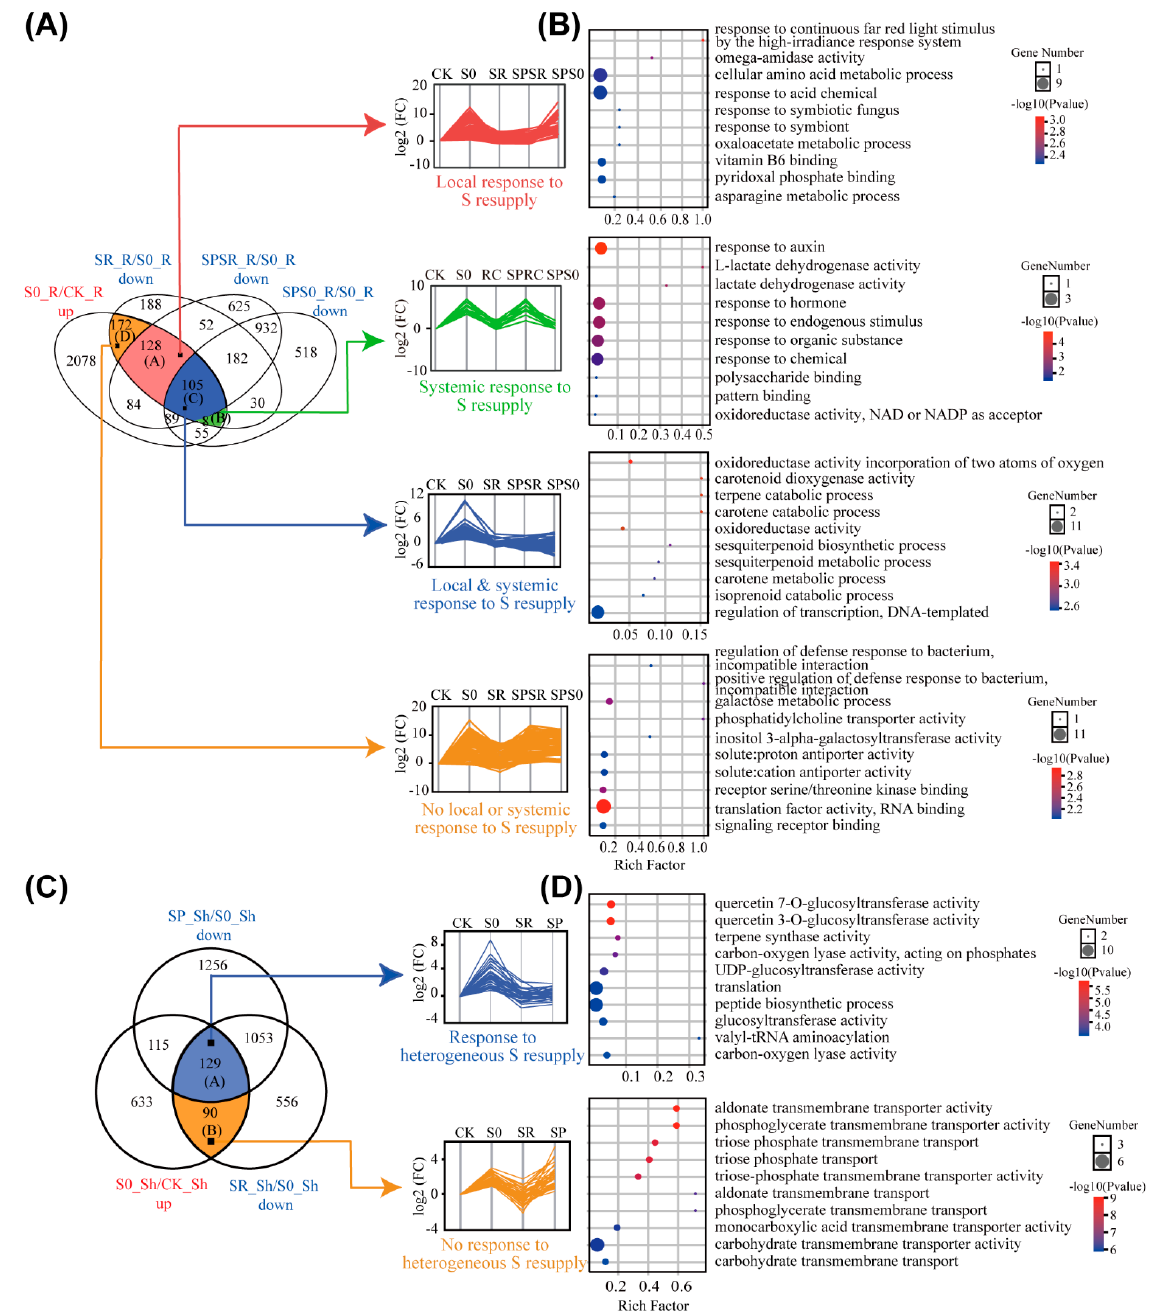
Figure 4. Root and shoot up-regulated DEGs in response to homogeneous and heterogeneous sulfate resupply. ( A ) Identification of root up-regulated DEGs with local response, systemic response, simultaneous local and systemic response, and no response to sulfate resupply by gene expression trend analysis and Venn diagramming. Different types of response genes were classified into Gene set A, B, C, and D, respectively, as shown in Table S5. ( B ) GO enrichment analysis of different types of response genes in ( A ). The top 10 GO terms with lowest p -values were shown. ( C ) Identification of shoot up-regulated DEGs responding to homogeneous and heterogeneous sulfate resupply, which were classified into Gene set A and B as shown in Table S6. ( D ) GO enrichment analysis of different types of response genes in ( C ). The top 10 GO terms with lowest p -values were shown. CK, control; S0, S deficiency; SR, sulfate resupply in both sides of split-roots; SPSR, the split-root halve with sulfate resupply; SPS0, the split-root halve remained in S deficiency. Sh, shoot; R,